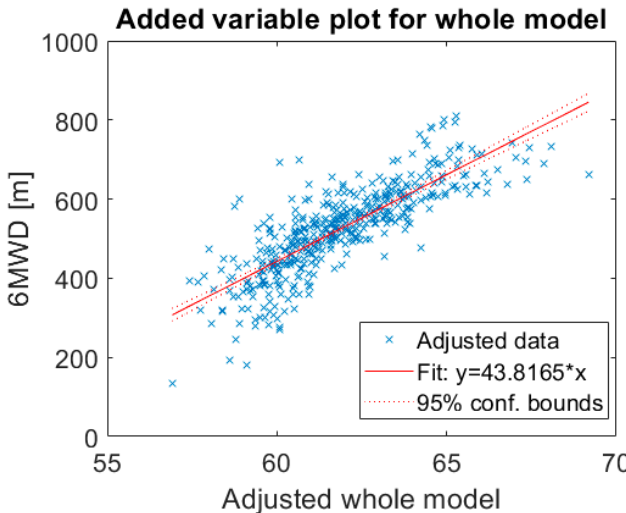
Figure 1. Added variable plot for the whole model. The adjusted whole model visualizes the fit of two independent variables (effort and chronotropic response) against the dependent variable. 6MWD, 6-min walking distance. R-squared: 0.661, p -value < 0.001.